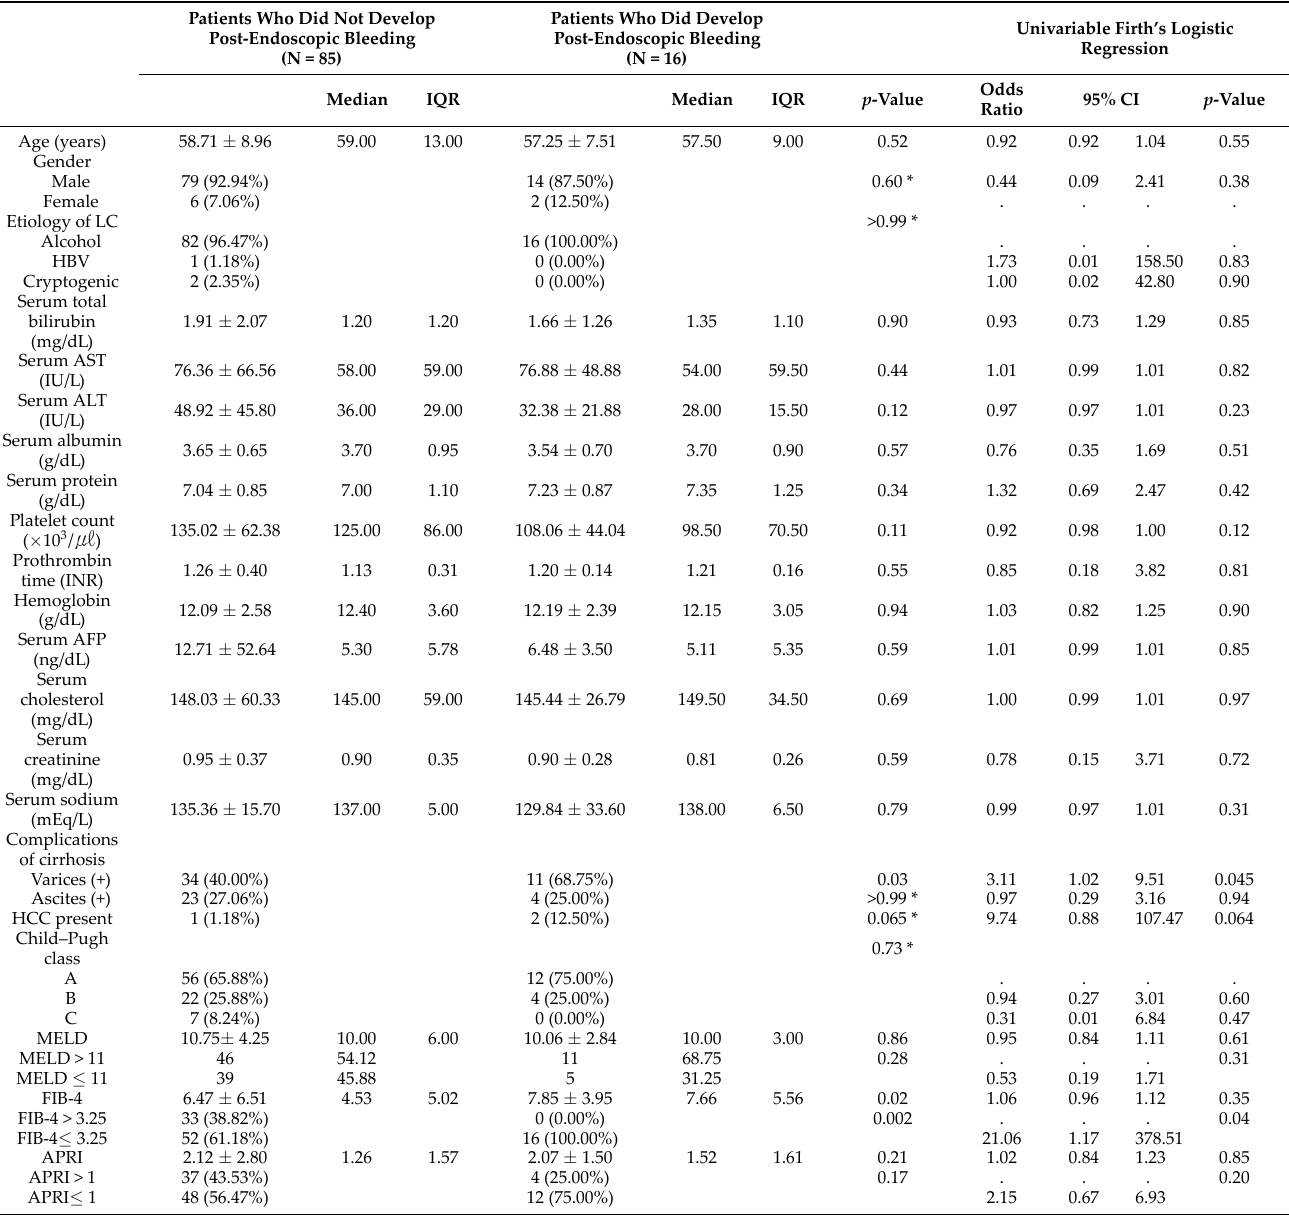
Table 1. Clinical characteristics of patients with liver cirrhosis who underwent the endoscopic pro- cedure. All patients (N = Table 3. Clinical characteristics of patients with LC who underwent colonoscopic polypectomy–EMR (N = 85).